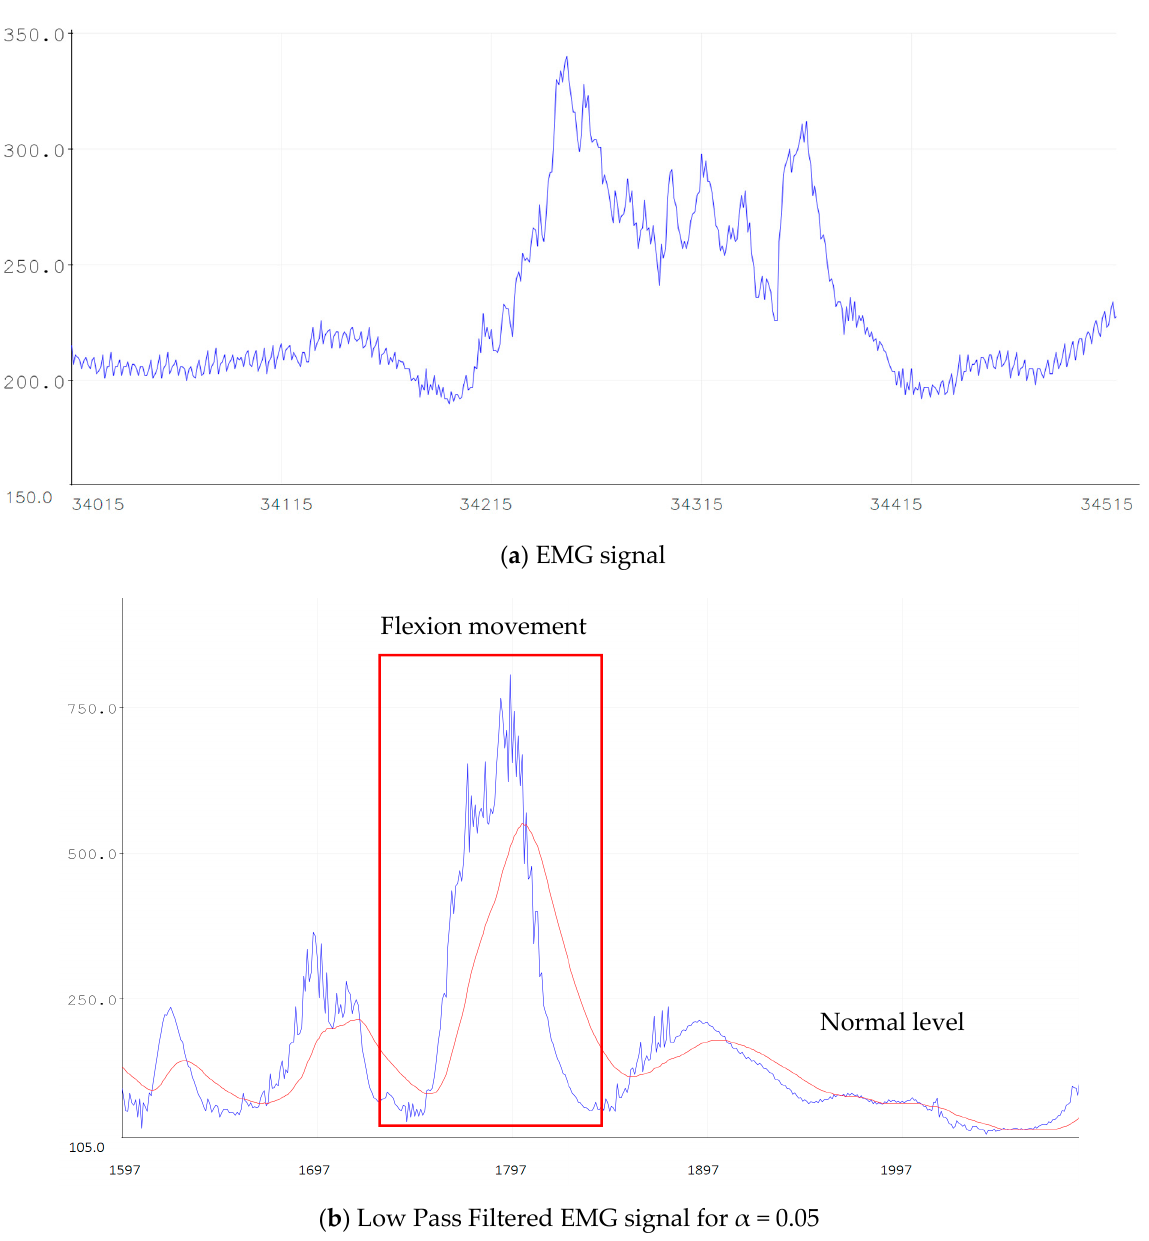
Figure 8. Example of EMG signal.